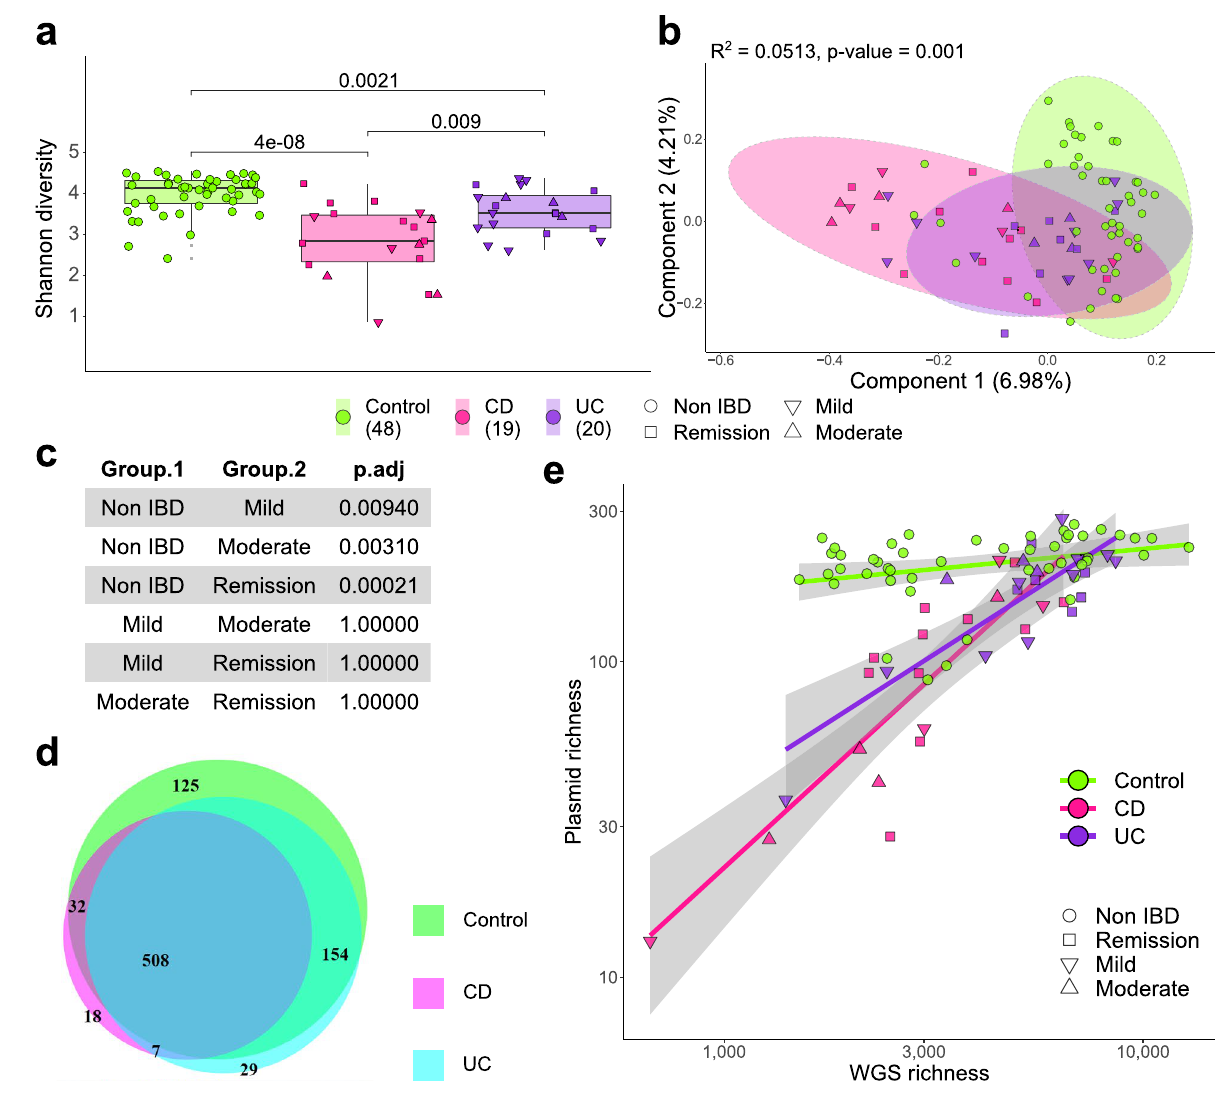
Figure 5. Intra-sample plasmidome differences are associated with IBD. ( a ) Shannon index α-diversity comparisons, and ( b ) β-diversity PCoA ordination of Canberra distances, of control, CD, and UC plasmidomes. The shape aesthetic indicates the recorded severity of patients with IBD, with the number of samples analysed per cohort displayed in brackets within the legend. ( c ) Wilcoxon signed-rank test with Bonferroni-correction to assess statistical significance of plasmidome α-diversity differences between non-IBD controls and patients with IBD grouped by disease severity. ( d ) Proportional Venn diagram of human plasmidome database plasmids detected across the total control, CD, and UC cohorts. The majority of plasmids are detected within all three cohorts (508 of 873 plasmids), with only 18 and 29 plasmids unique to CD and UC, respectively. ( e ) Scatter plot of plasmid richness compared to the overall total microbiome sample richness. The shape aesthetic highlights the reported severity of patients with IBD, with the shading around the linear model regression line representing a 0.95 confidence